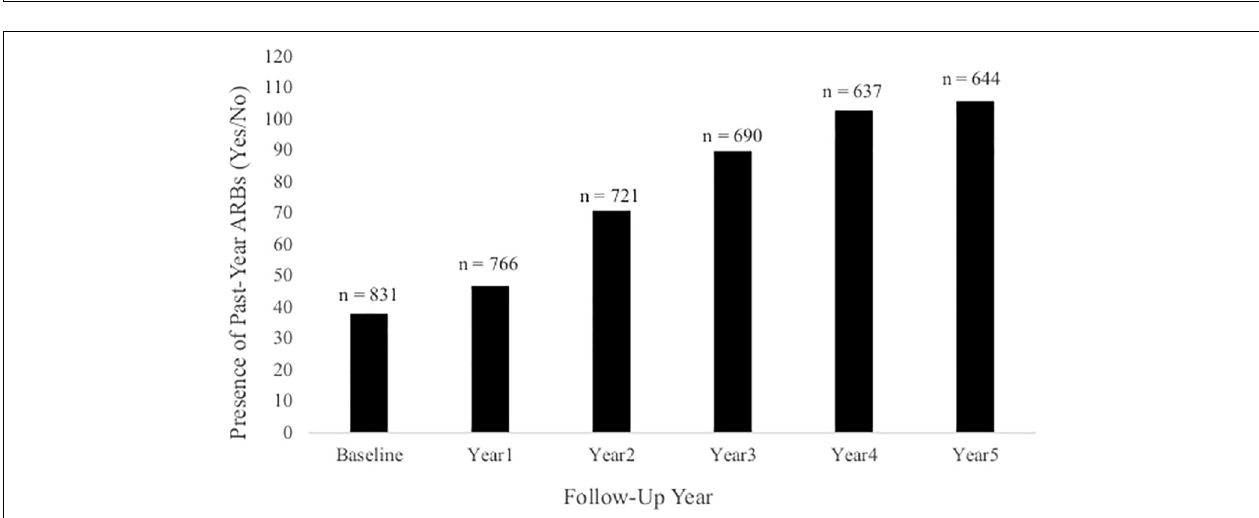
FIGURE 3 | The presence of past-year ARBs (yes/no) at each annual follow-up. This figure illustrates the frequency of participants at each annual follow-up who had experienced at least one past-year ARB. Total sample size at each annual follow-up is indicated above each column.